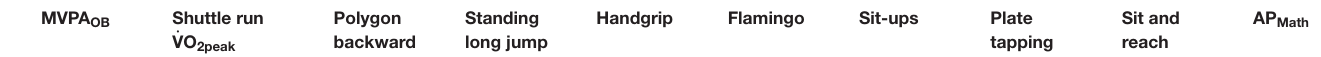
TABLE 2B | Correlation coefficients for dependent measures determined for boys and girls in Grade 9. Grade 9